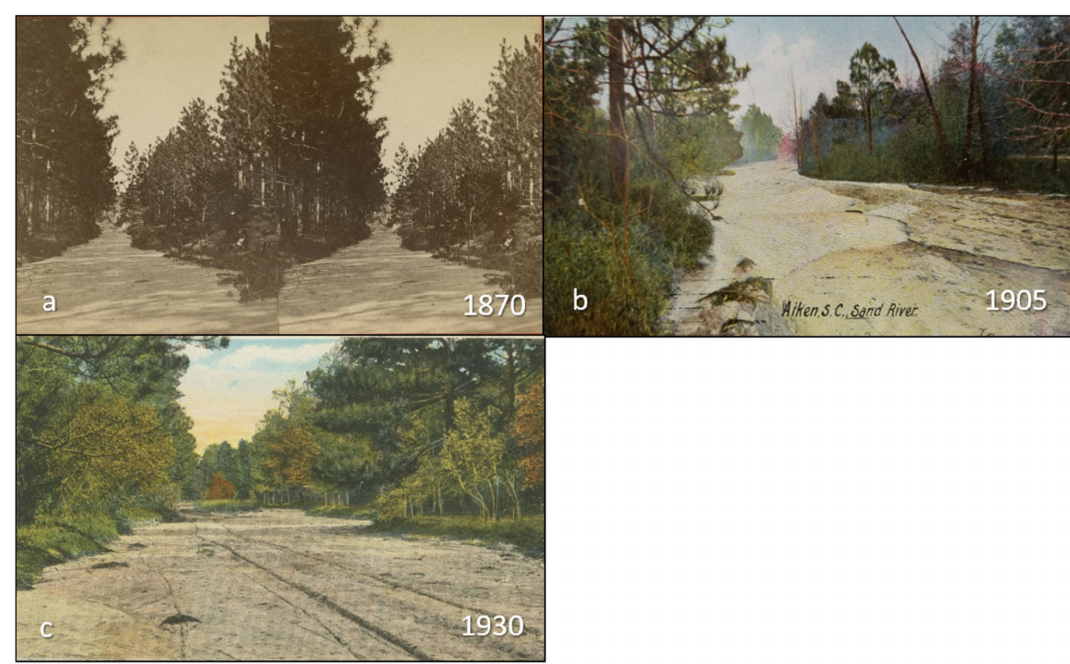
Figure 2. ( a ) A stereo pair image from 1870, and postcard images from ( b ) and ( c ) 1930 reveal the shallow nature of the pre-urbanized Sand River channel. The images reveal no apparent change in the channel morphology over the 60-year